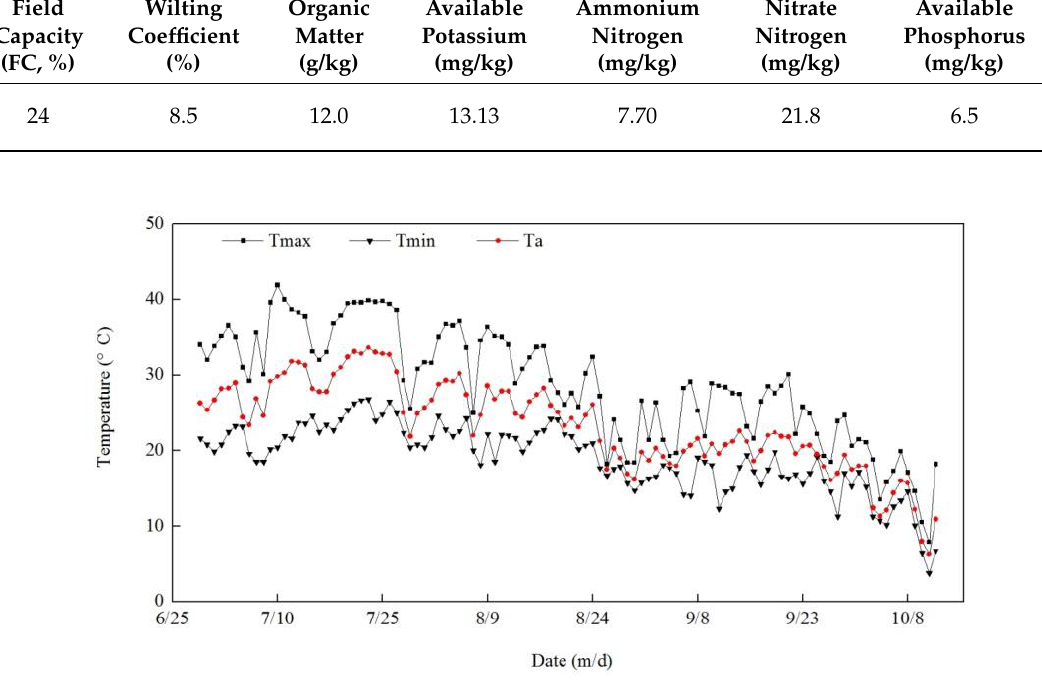
Table 2. Treatments of the experimental